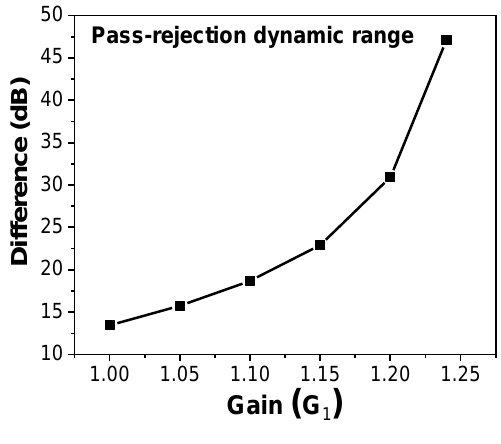
Figure 8. Dynamic range for frequencies ( 2   m ), as a function of gain (G structure